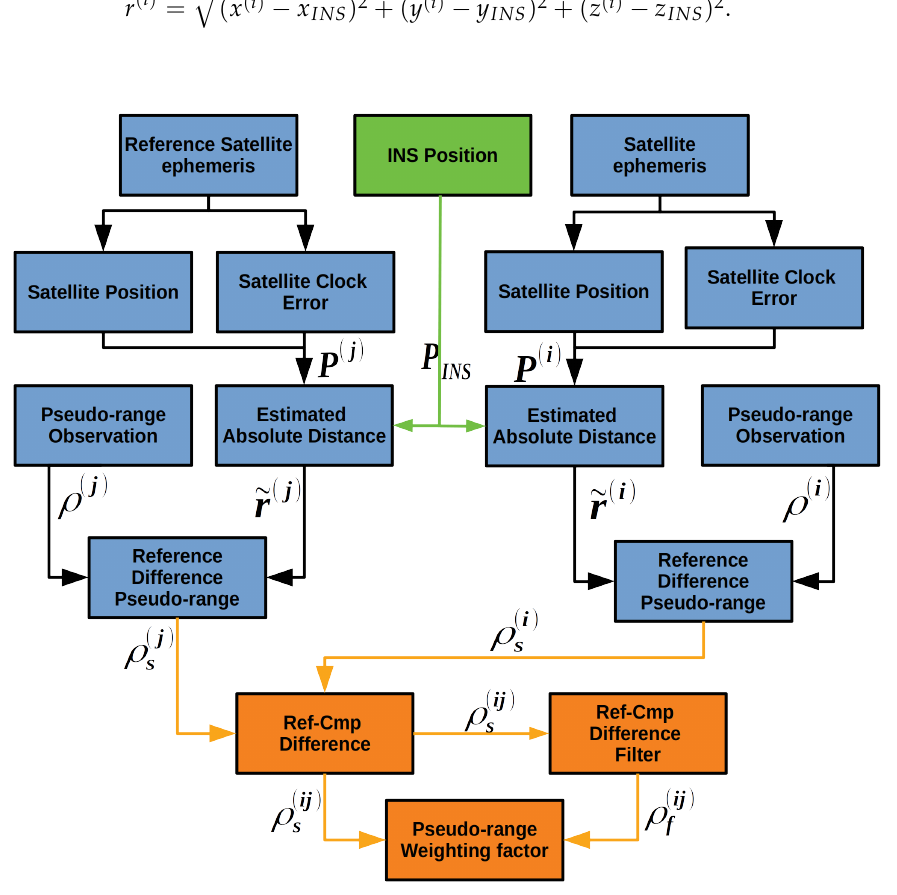
Figure 6. Diagram of INS aided pseudo-range weight control algorithm in